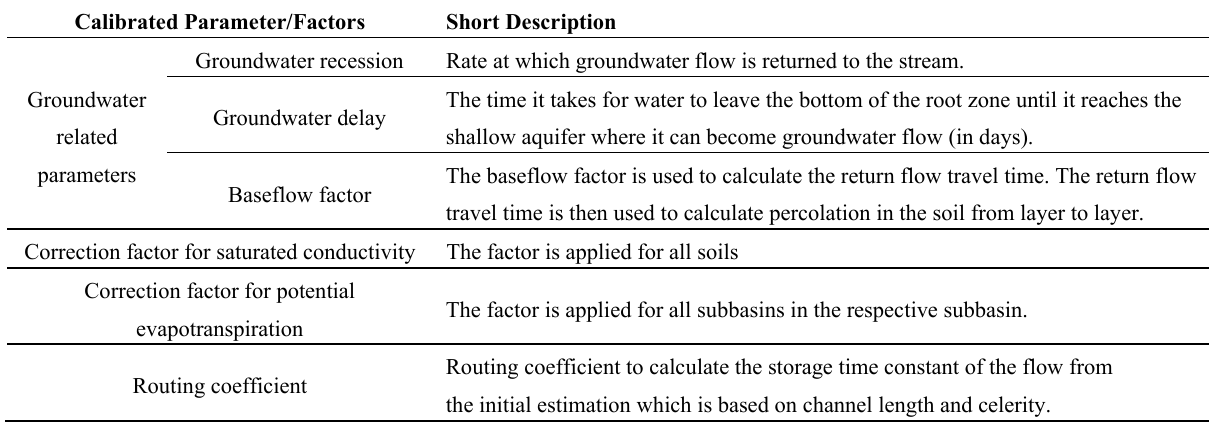
Table 1. Calibrated parameters of the ecohydrological model SWIM (Soil and Water Integrated Model) with a short description.